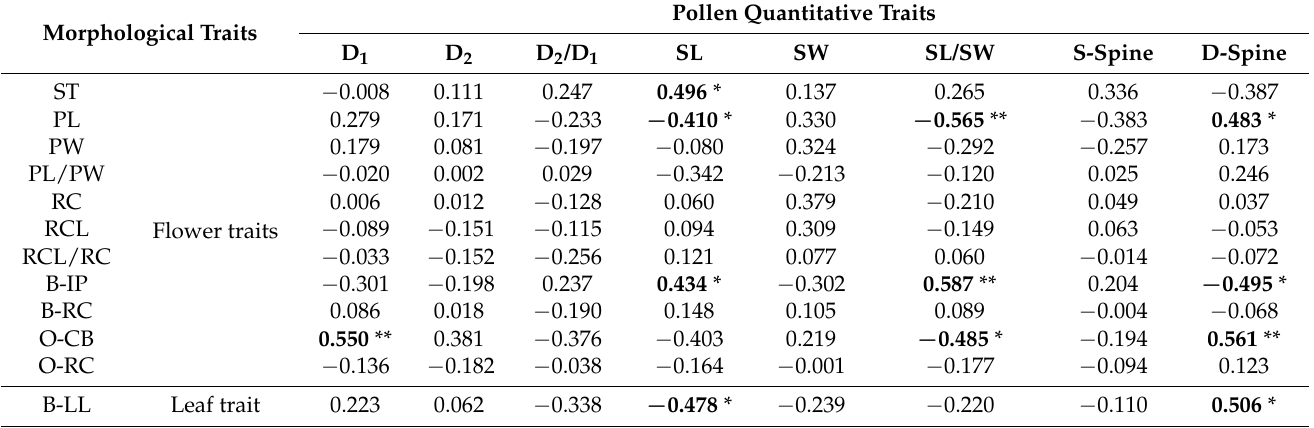
Hibiscus syriacus